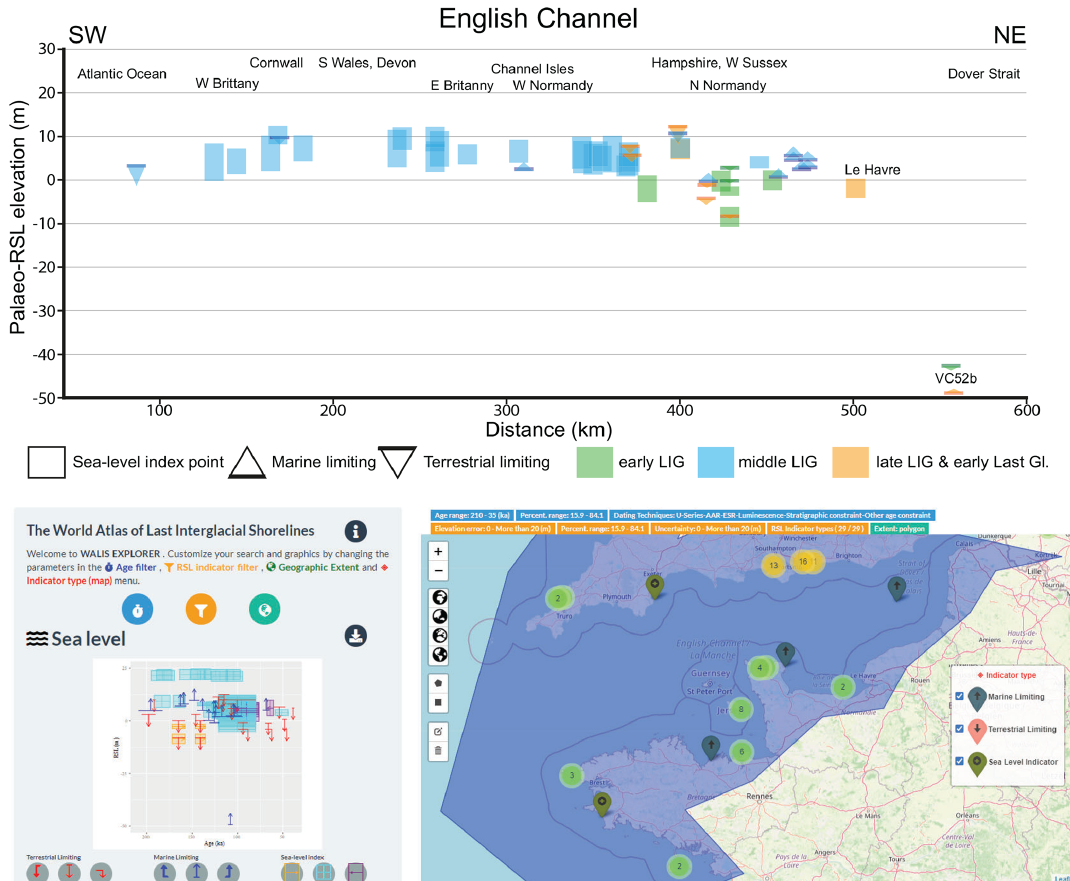
Figure 5. SW–NE-organised plot of Last Interglacial WALIS data entries for the English Channel, split into type and relative position. Transect location in Fig. 1. Colour coding separates data points of middle-LIG relative age from those attributed to earlier and later phases within the LIG (see also Table 1). Bottom panel shows sites and age–depth plot as a screenshot of WALIS’ interactive viewer (Garzon and Rovere, 2021): https://warmcoasts.eu/world-atlas.html (last access: 30 April 2022), which includes data as basemap ©